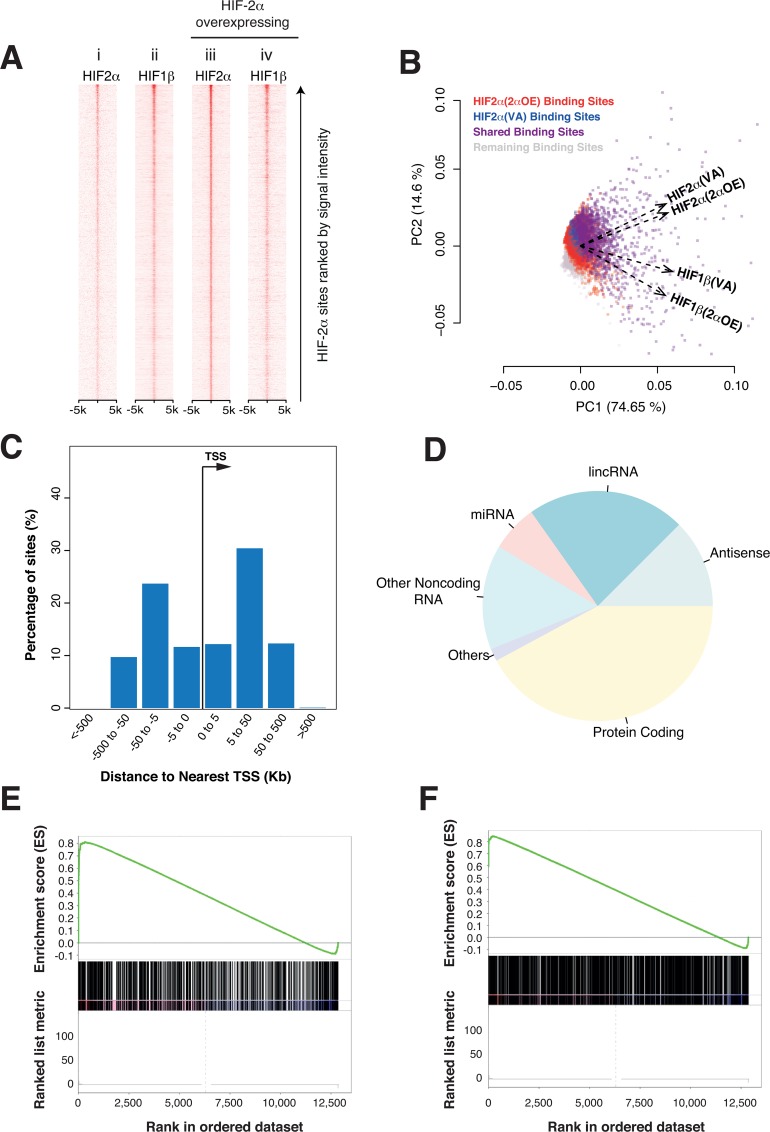
HIF-2α overexpression in 786-O cells.(A) HIF-2α binding sites in the HIF-2α overexpressing cells were identified by peak calling and ranked on the vertical axis according to signal intensity. Heat maps of these sites (±5kb on horizontal axis) showing ChIP-seq read density for the indicated HIF subunits were generated for both the control cells (i, ii) and the cells with HIF-2α overexpressed (iii, iv). In contrast to re-expressed HIF-1α, overexpressed HIF-2α binds to a large number of sites (compare i and iii), without HIF-1β (compare iii and iv) and has little effect on the distribution of HIF-1β (compare ii and iv). (B) Biplot showing Principal Component Analysis (PCA) of ChIP-seq signal intensity (RPKM values) for both individual binding sites (dots) and HIF-subunits (vectors) across all HIF-binding sites identified in control cells and in HIF-2α overexpressing cells. Sites binding endogenous HIF-2α in control cells are shown in blue while sites binding re-expressed HIF-1α are shown in red, sites binding both are colored purple and the remaining sites are colored grey. PCA for HIF subunits shows that HIF-2α and HIF-1β co-vary more closely in the control cells (compare HIF2α(VA) and HIF1β(VA)) than in the overexpressing cells (compare HIF2α(2αOE) and HIF1β(2αOE)). (C) Histogram of the distance to nearest transcription start site (TSS) for HIF-2α binding sites in cells overexpressing HIF-2α. (D) HIF-2α binding sites in the HIF-2α overexpressing cells were categorized according to the class (Ensemble) of the nearest gene. The relative frequency of each class is shown by pie chart. Gene set enrichment analysis (GSEA) for the set of genes nearest to (E) HIF-2α binding sites in the control cells and (F) newly identified HIF-2α binding sites in the overexpressing cells, when genes are ranked according to fold-change and significance in mRNA expression following overexpression of HIF-2α (horizontal axis).